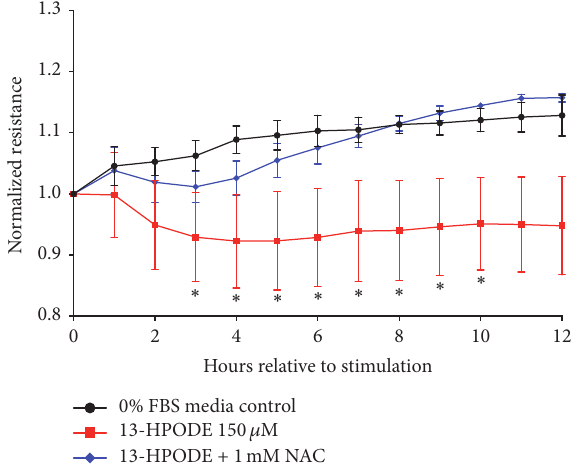
Figure 9: Mean normalized endothelial resistance across time during media control ( ), 150 𝜇 M 13-HPODE ( ), and 150 𝜇 M 13-HPODE + 1mM N-acetylcysteine (NAC) ( ) exposure is displayed in Figure 9. Resistance of BMEC monolayer across time for each treatment group (control, 13-HPODE, and 13-HPODE + NAC) is normalized relative to time 0. Significance of differences in resistance across time between treatment groups was tested by a two-way repeated measures ANOVA and adjusted by Bonferroni’s multiple comparisons test. An asterisk ( ∗ ) represents significance declared at 𝑃 ≤ 0.05 . There were no significant differences detected between media control and 13-HPODE + 1mM